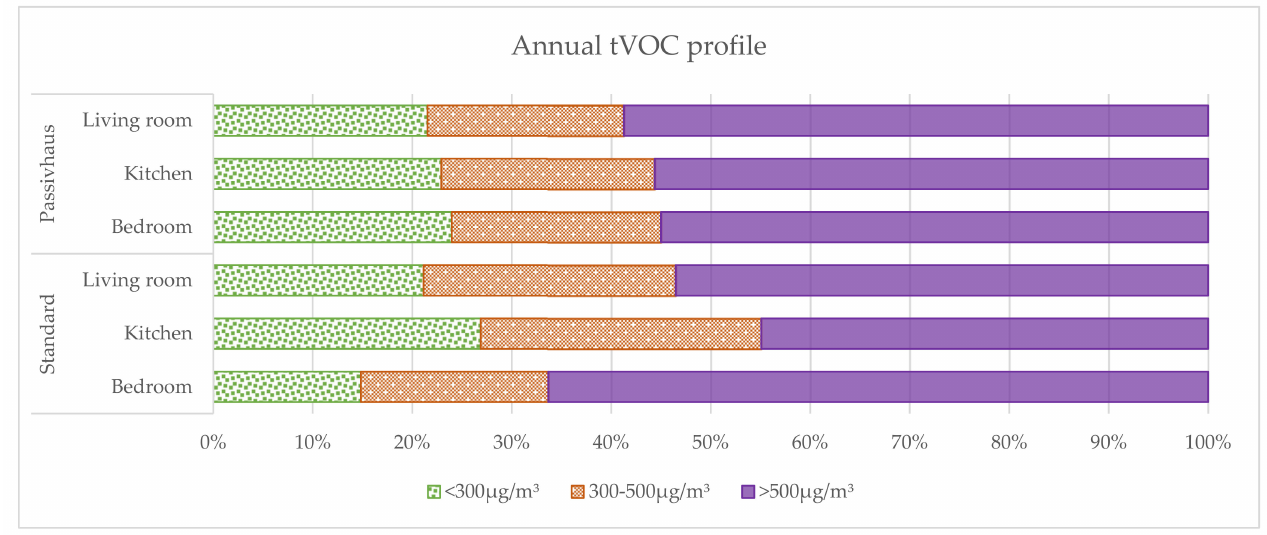
Figure 7. Annual tVOC profile in the Passivhaus and Standard dwellings. Source: